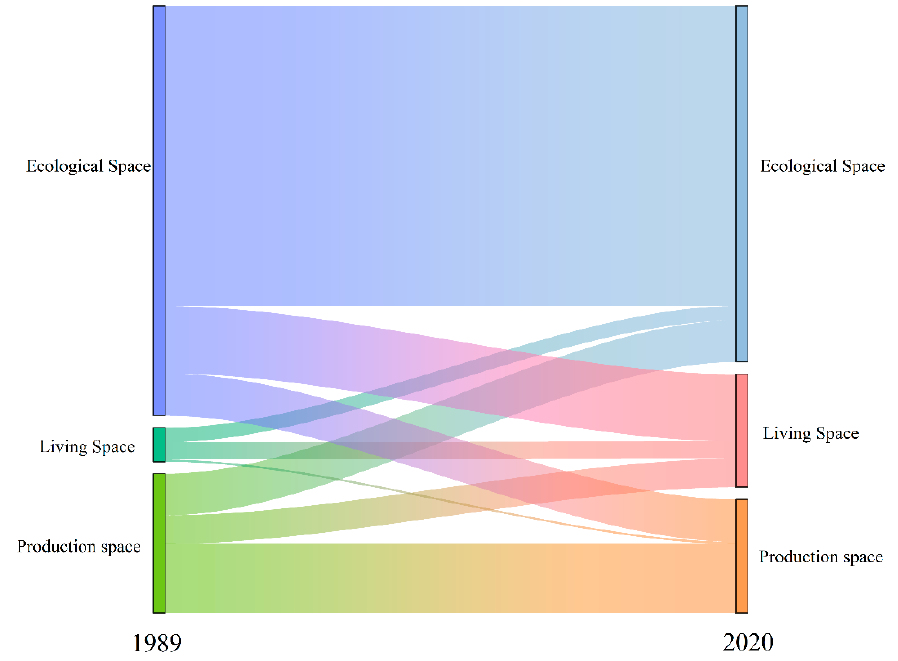
Figure 6. PLE space type conversion Sankey diagram in the Poyang Lake area from 1989 to 2020.